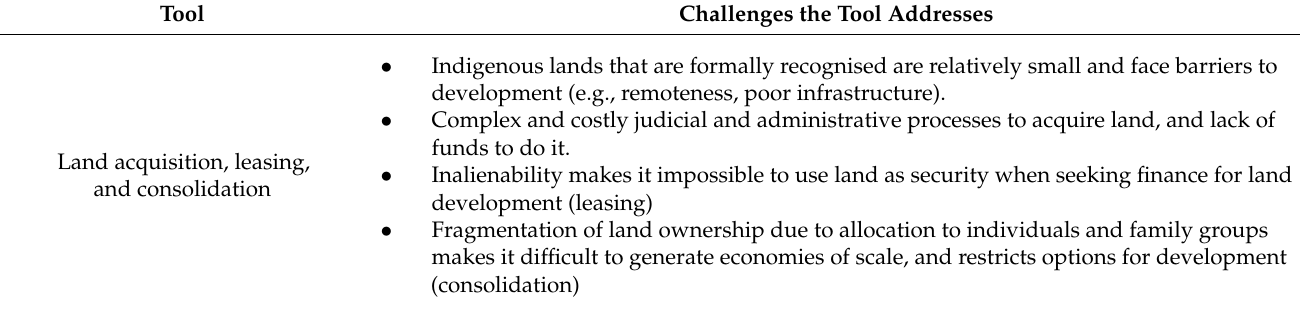
Table 2. Cont. Tool Challenges the Tool